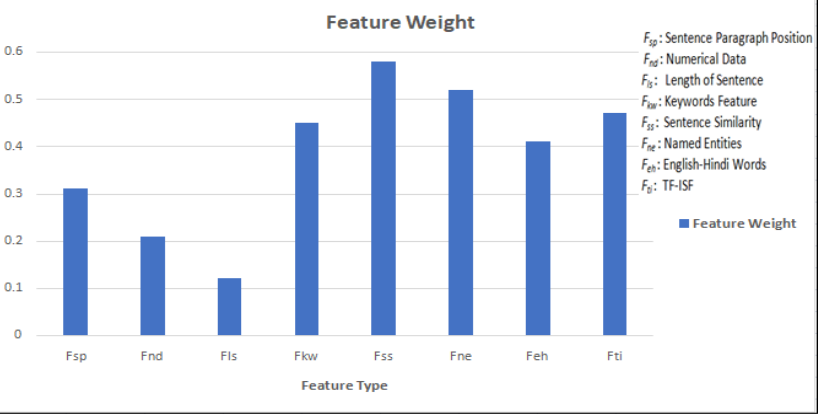
Figure 3. Feature weights for different features.